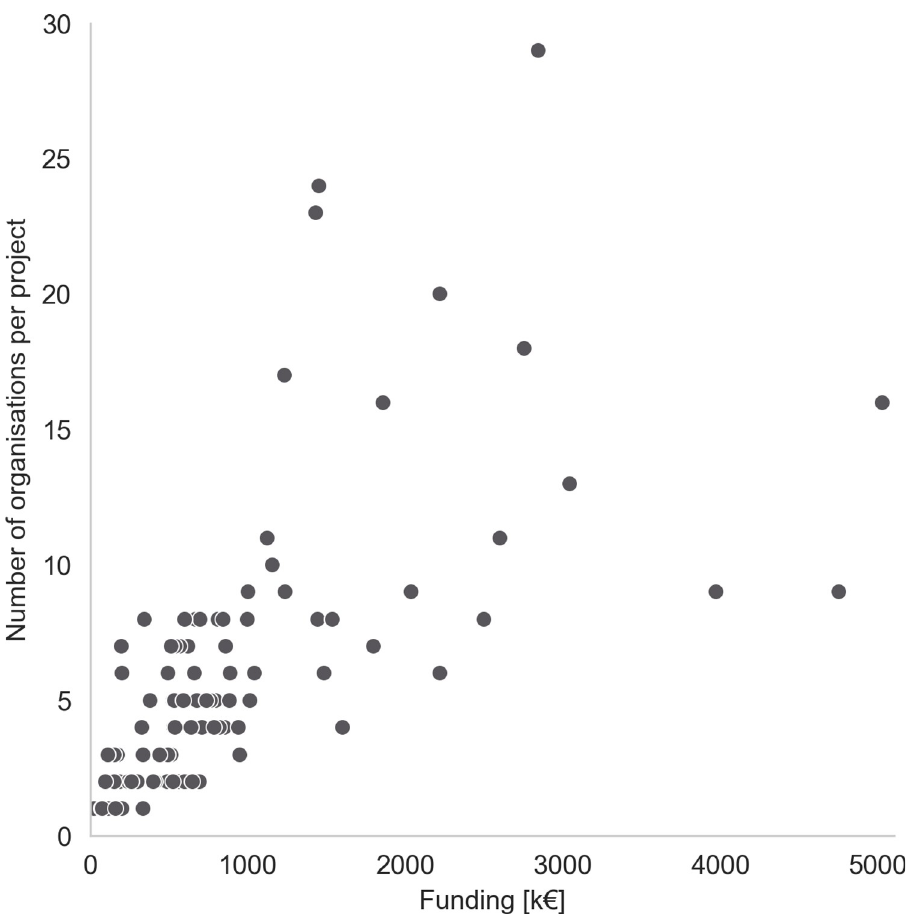
Fig 3. Scatter plot of Number of organizations per project (incl. lead partner) against funding in k €